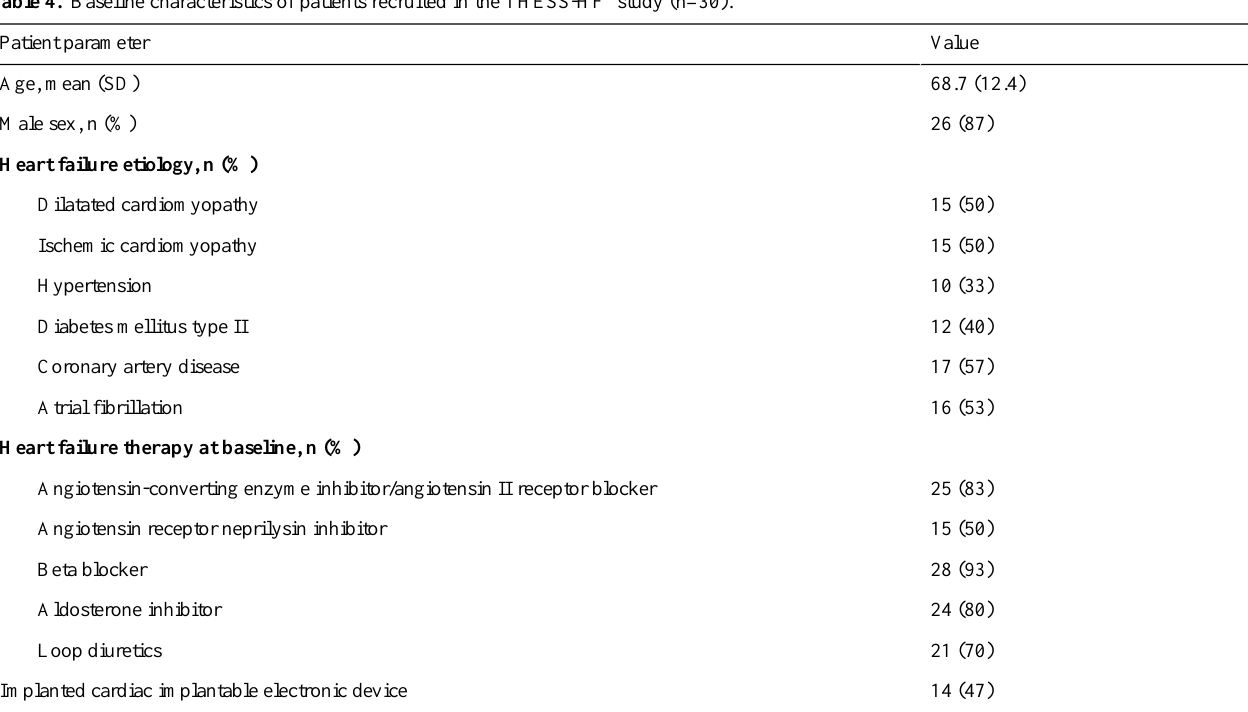
Table 4. Baseline characteristics of patients recruited in the THESS-HF a study